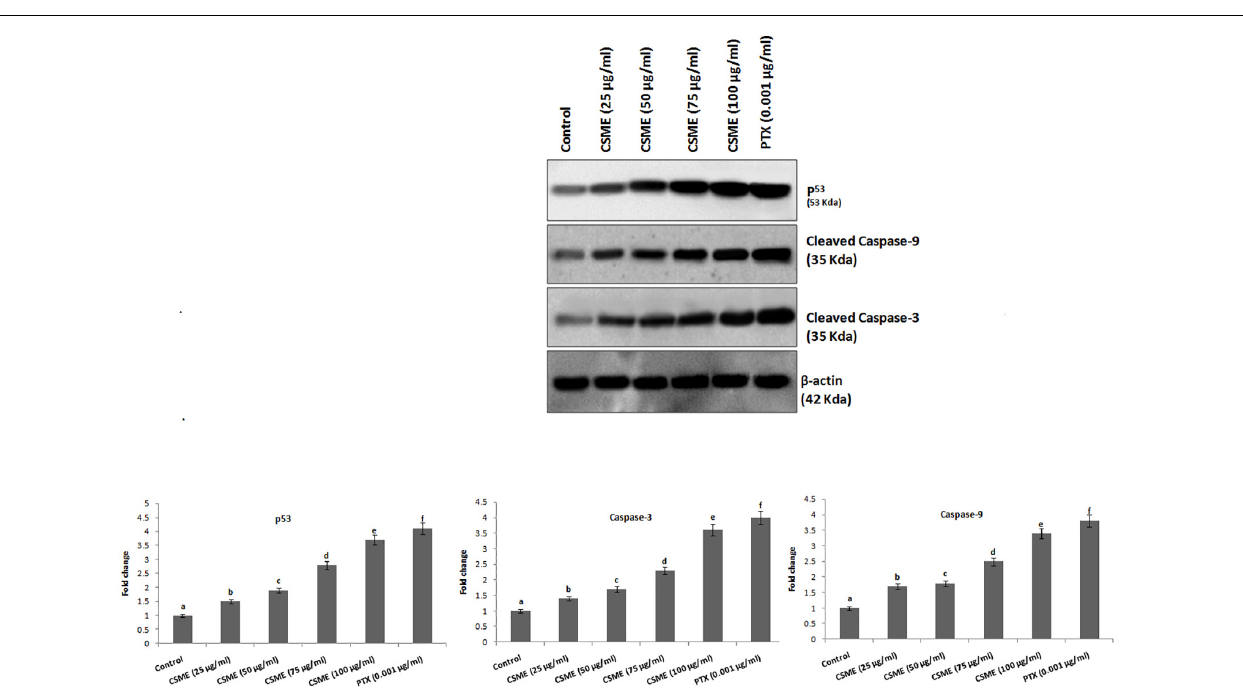
Frontiers in Cell and Developmental Biology |